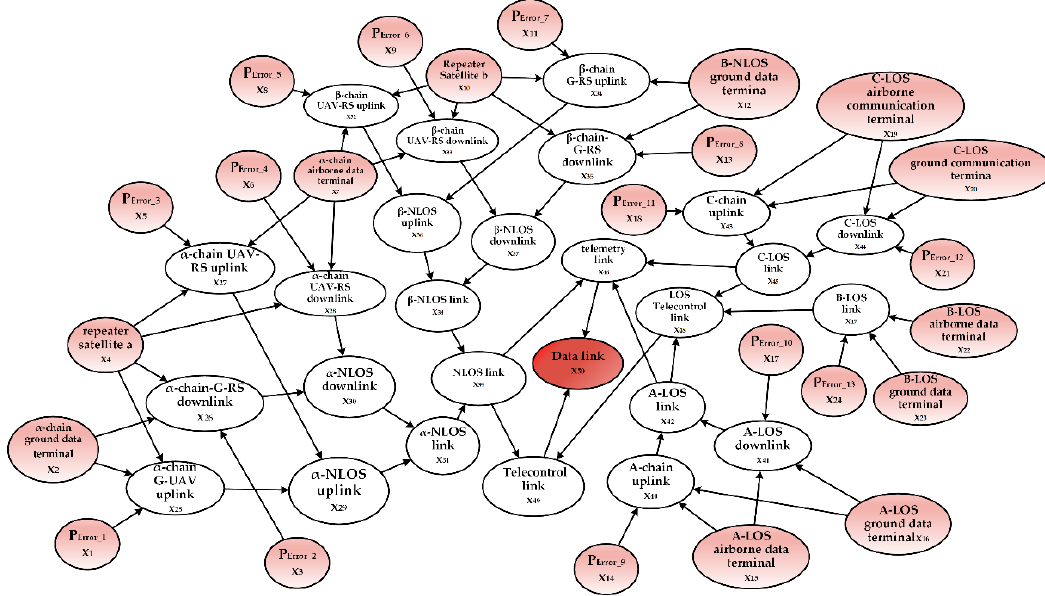
Figure 8. Communication distance distribution curve of each link of solar-powered UAV data-link system. ( a ) Communication distance of UAV-Satellite links; ( b ) Communication distance of ground- satellite links.